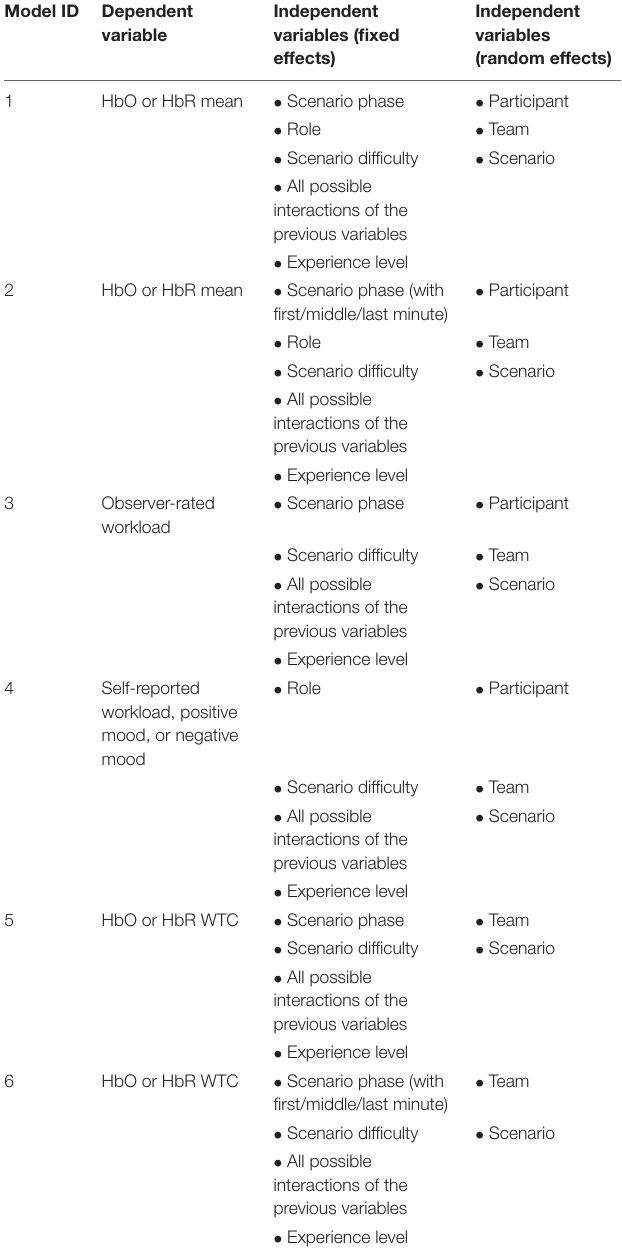
TABLE 2 | LME model specifications.